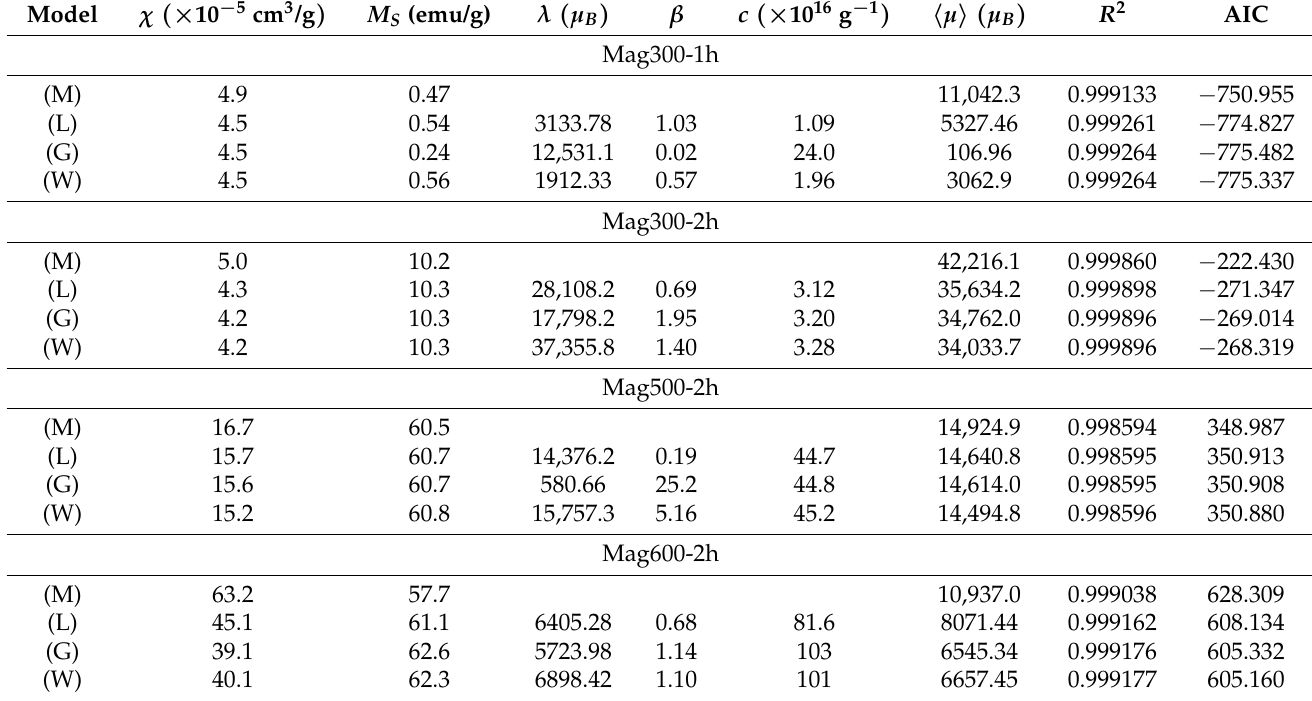
Table 1. Parameters of the models (M) Modified Langevin function, (L) Lognormal, (G) Gamma and (W) Weibull obtained by fitting the magnetization curve of the Mag300-1h, Mag300-2h, Mag500-2h and Mag600-2h samples. The mean magnetic moment (in Bohr magnetons, µ B), the coefficient of determination R and the Akaike information criterion (AIC) value are also shown. Although models (L), (G) and (W) do not have an M S parameter, it is convenient to define M S = c (cid:104) µ (cid:105) in these